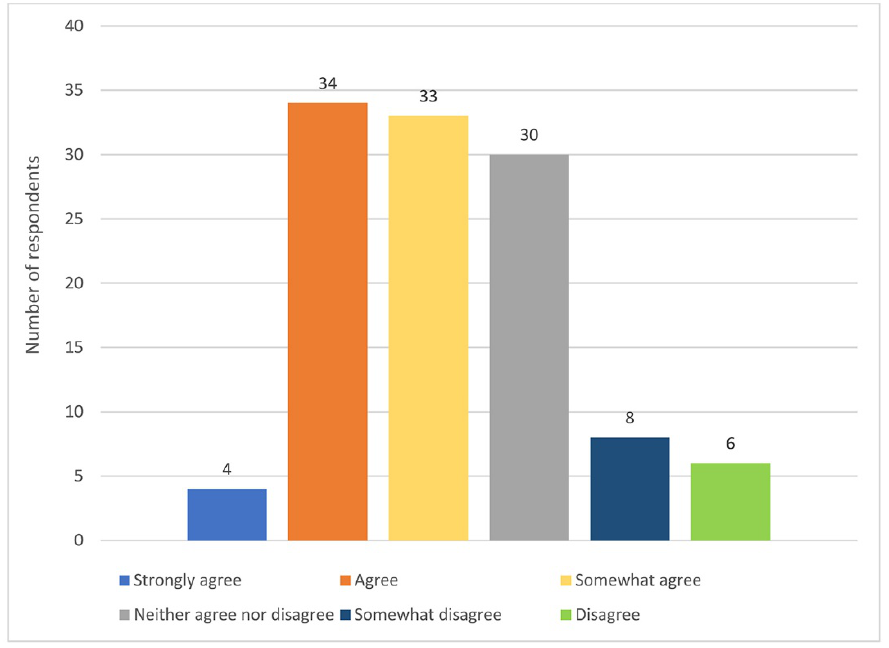
Figure 5 Respondents’ interest in institutional initiatives to foster intergenerational